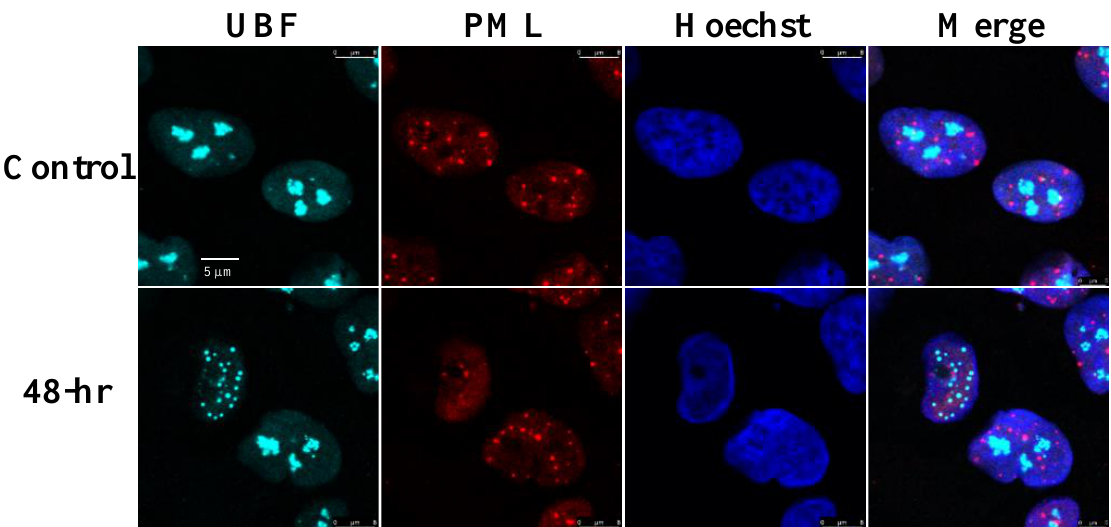
Figure 2. UBF does not colocalize with PML bodies. BAC16-infected iSLK cells were treated for 48 h with 1 µg/mL Dox and 1 mM n-Butyrate to induce lytic reactivation. Uninduced BAC16-infected iSLK cells were used as a control. Cells were stained with anti-PML followed by Rhodamine-conju- gated secondary antibody. Subsequently, the cells were incubated with antibodies to UBF, and then with anti-rabbit Cy5 secondary antibody. Chromatin was detected by Hoechst staining.